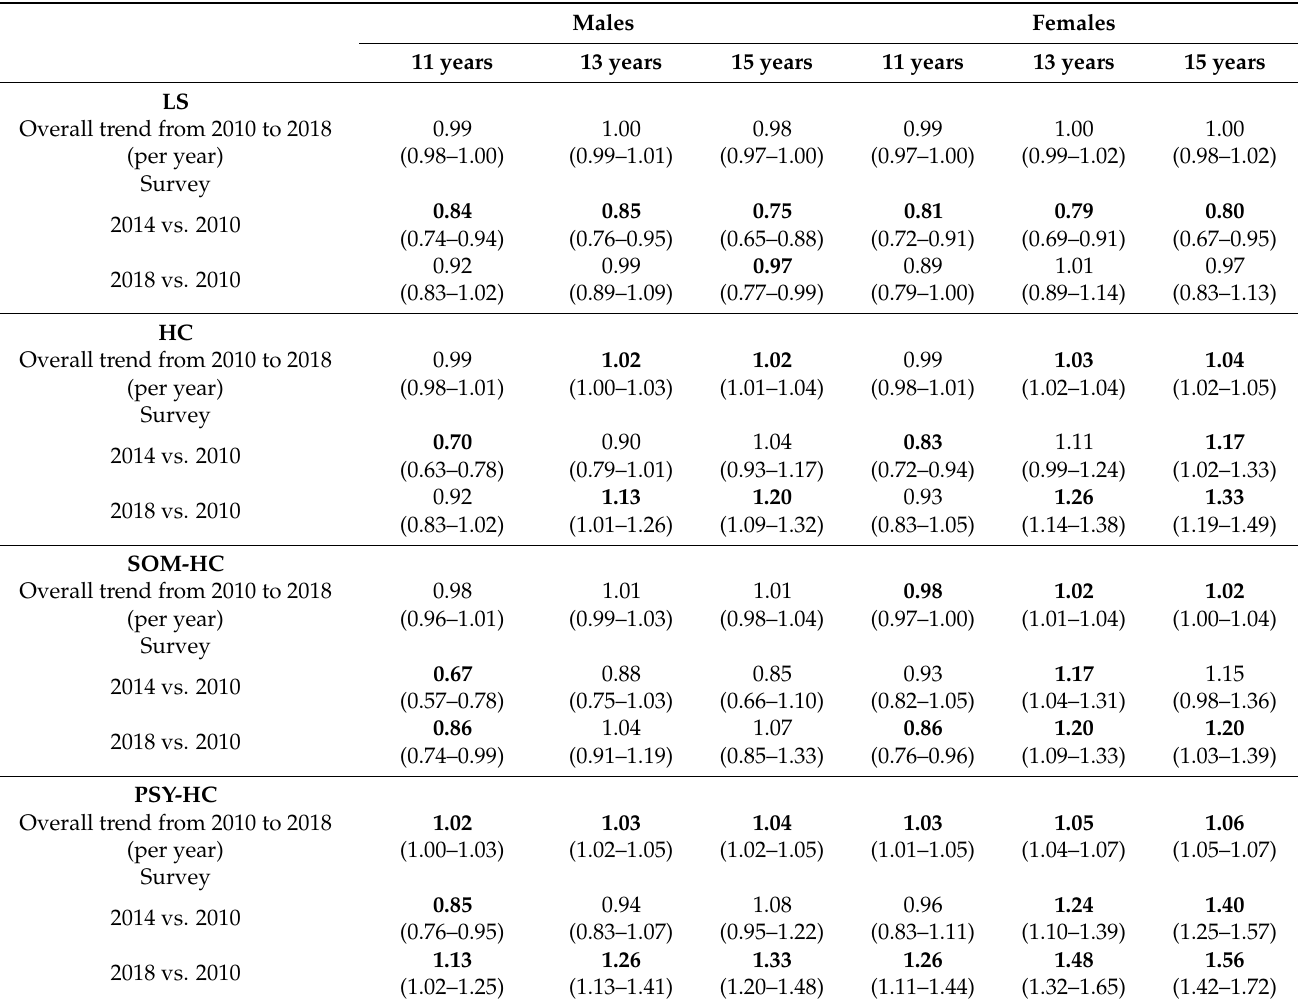
Table 2. Trend 2010–2018 of LS, HC, PSY-HC, and SOM-HC, stratified by gender and age groups. Results are reported as OR